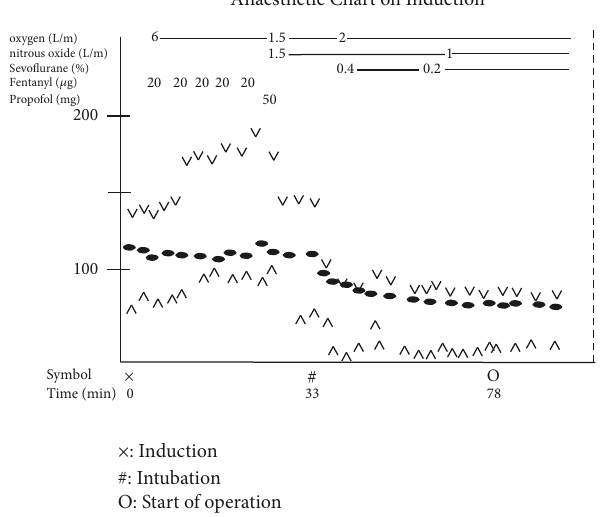
Figure 5: Anaesthetic chart of patient undergoing thyroidectomy. × : induction, #: intubation, and O: start of operation.